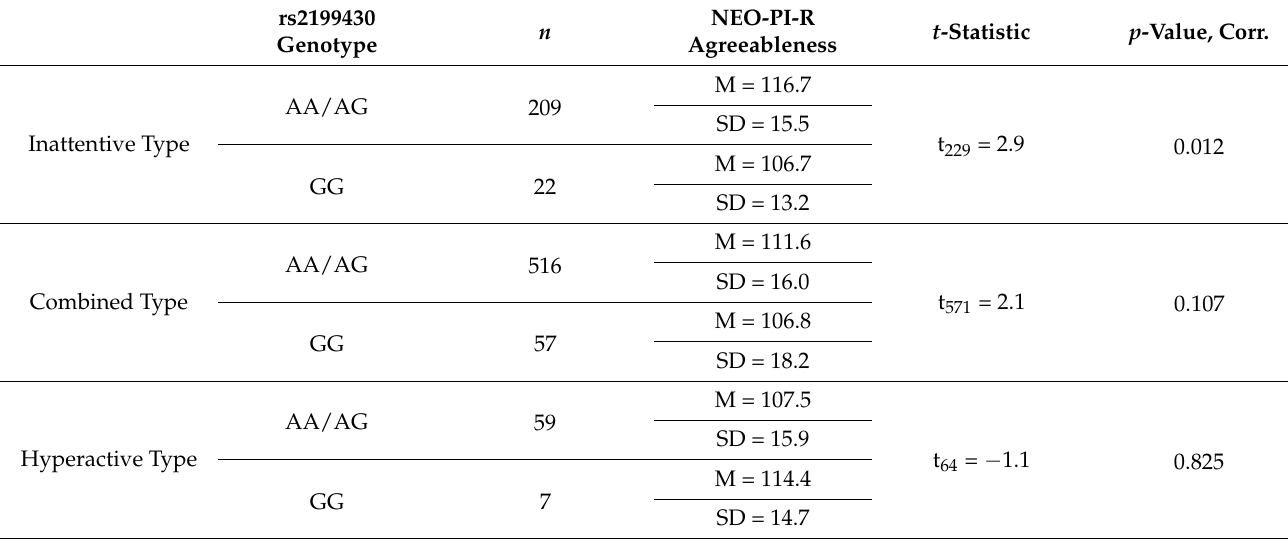
Figure 1. Association of CDH13 rs2199430 genotype with agreeableness. In the adult ADHD cohort ( A ) CDH13 rs2199430 genotype was significantly associated with the personality trait of agreeableness as assessed by the NEO-PI-R questionnaire (ANCOVA, p = 0.007, 0.035 corr.), which was due to significantly lower agreeableness scores in GG allele carriers as compared to AA and AG allele carriers. Post hoc analyses by t-tests revealed that the effect is present both in the female and in the male subgroup of the aADHD cohort. In the healthy control group ( B ) CDH13 rs2199430 GG allele carriers likewise exhibited lower agreeableness scores than AA/AG allele carriers. Bars represent means +/ − SEM, ** p < 0.01, * p < 0.05. Table 1. ADHD subtype-dependent association of rs2199430 genotype with agreeableness.